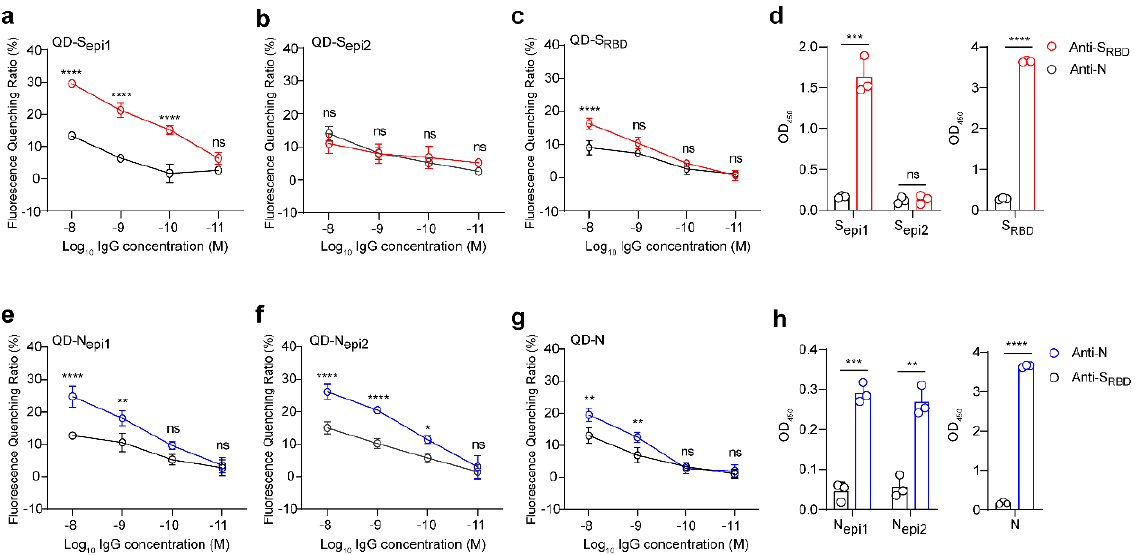
Figure 4. QDs coupled with four highly sensitive SARS-CoV-2 peptides efficiently respond to the corresponding antibody. ( a – c ) Reactivity of QDs coupled with S epi1 ( a ), S epi2 ( b ), and S RBD ( c ) to the anti-S RBD antibody (red) and anti-N antibody (black). ( d ) Reactivity of S epi1 , S epi2, and S RBD to the anti-S RBD antibody (red) and anti-N antibody (black) by ELISAs. ( e – g ) Reactivity of QDs coupled with N epi1 ( e ), N epi2 ( f ), and the recombinant N protein ( g ) to the anti-N antibody (blue) and anti-S RBD antibody (black). ( h ) Reactivity of N epi1 , N epi2, and the recombinant N protein to anti-N antibody (blue) and anti-S RBD antibody (black) by ELISAs. All values represent the means ± SD of three independent experiments. Statistical analyses were carried out with unpaired t -tests for ELISAs and two-way ANOVA for fluorescence quenching ratio comparisons. * p < 0.05, ** p < 0.01, *** p < 0.001, **** p < 0.0001, ns,